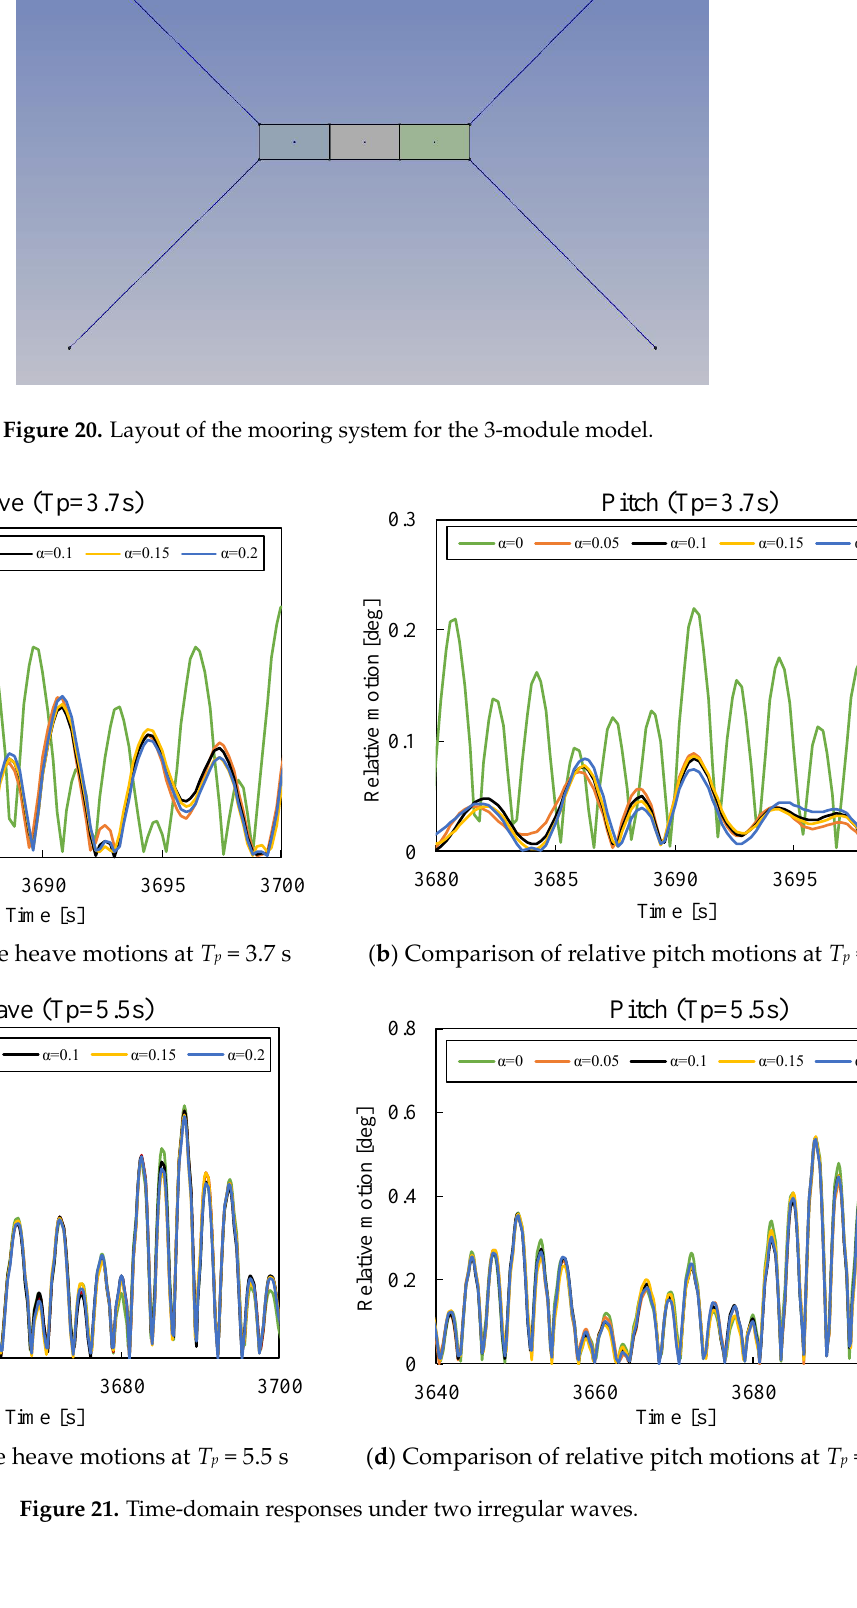
( a ) Comparison of the maximum and significant relative heave motions for different damping ratios ( b ) Comparison of the maximum and significant relative pitch motions for different damping ratios Figure 22. The statistical results of time-domain response, T p = 3.7 s. (maximum: the maximum value of the three-hour calculation; significant: 1/3 of the results in three hours). Since the mechanical characteristics of connectors between modules are closely re- lated to their relative motion. The statistics of the connector load for the configuration of a three-module system spaced 1 m apart with the range of artificial damping ratios 0–0.2 are plotted in Figure 23. It is found that for multi floaters connected by flexible connectors, the introduction of artificial damping lid factor does change the extreme issue, which can lead to a decrease of the connector load. Compared with the case without an artificial damping lid, the relevant load decreases significantly and the fender load corresponding to different damping coefficients stabilizes at about 40% of the no artificial damping lid introduced case with the intervention of artificial viscous damping. The same trend can be seen in cable, the load on the cable is also stable around a certain value and does not change with the increase of the coefficient significantly. Which is consistent with the above phenomena of time-domain and frequency-domain motion differences. Since the incident wave is irregular, the load of the connector is closer to the significant value un- der normal service conditions. It is more representative to analyze 1/3 load with the sig-